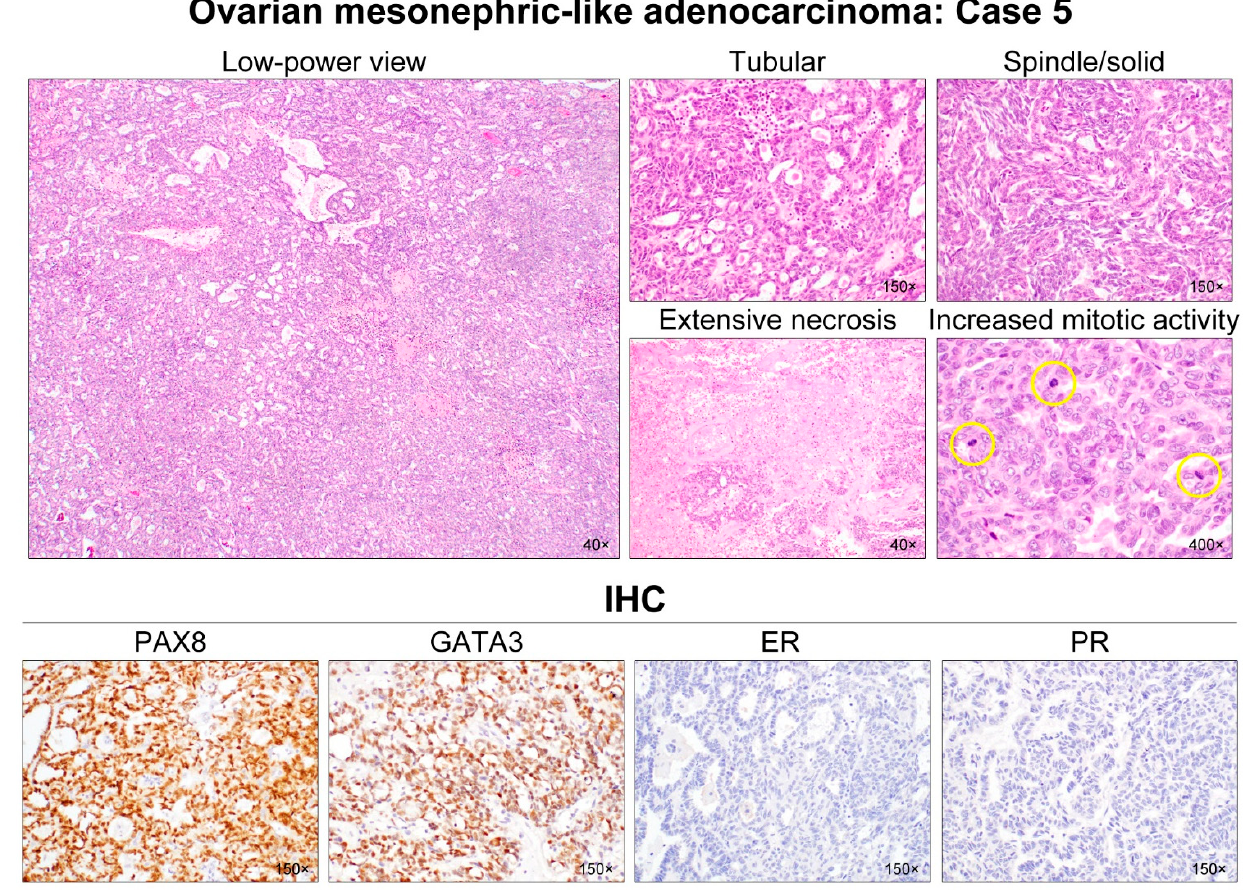
Figure 6. Histological features of ovarian MLA: Case 5. A 6-cm ovarian mass was purely solid and involved the right ovary and lateral uterine wall. A low-power magnification revealed a compact aggregation of numerous small tubules with tiny lumina, resulting in a sieve-like structure. Relatively uniform tubules were lined by columnar epithelial cells and contained dense eosinophilic intraluminal secretions. A few dilated, irregular-shaped ductal structures also possessed pale eosinophilic intraluminal substances. In several areas, the spindle-shaped tumor cells were intermingled with small tubules and showed fascicular and solid growth patterns. They displayed uniform, tapering nuclei. Although most of the tumor cells exhibited mild-to-moderate nuclear pleomorphism without conspicuous nucleoli, some foci showed severe nuclear pleomorphism, extensive coagulative tumor cell necrosis, and increased mitotic activity (yellow circles). This case was diagnosed as stage IIB disease based on the uterine and pelvic peritoneal extension. Immunostaining revealed that the tumor cells were diffusely and strongly positive for PAX8 and GATA3, but completely negative for hormone receptors.